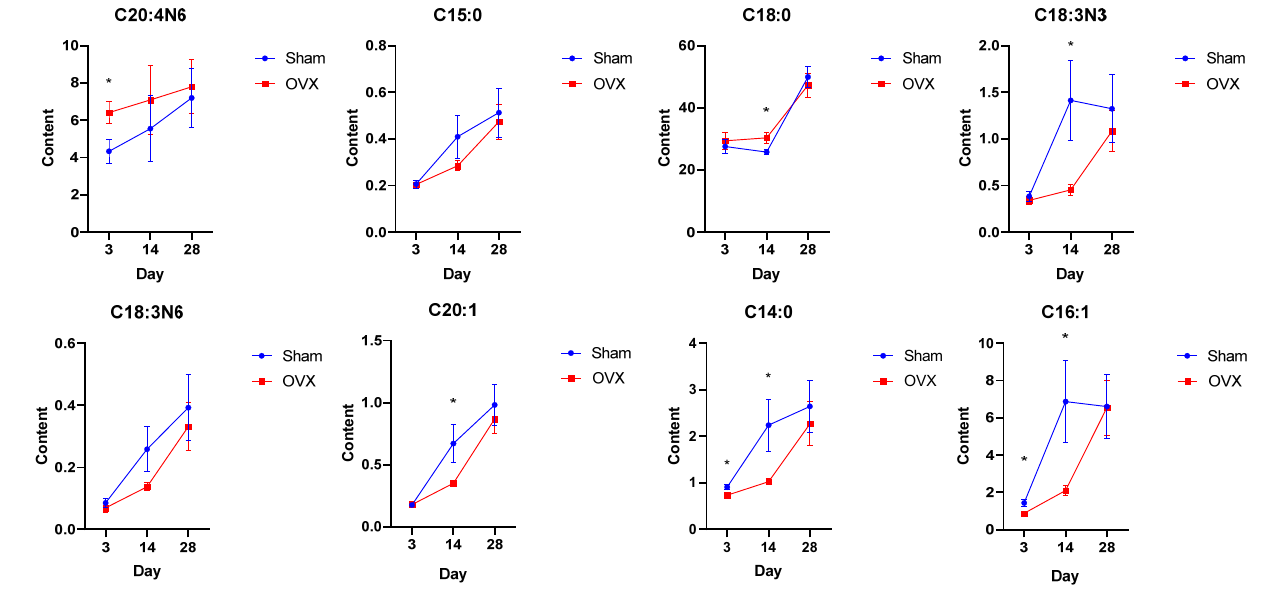
Figure 3. Concentration changes for significant bone marrow fatty acids after surgery. * p < 0.05.